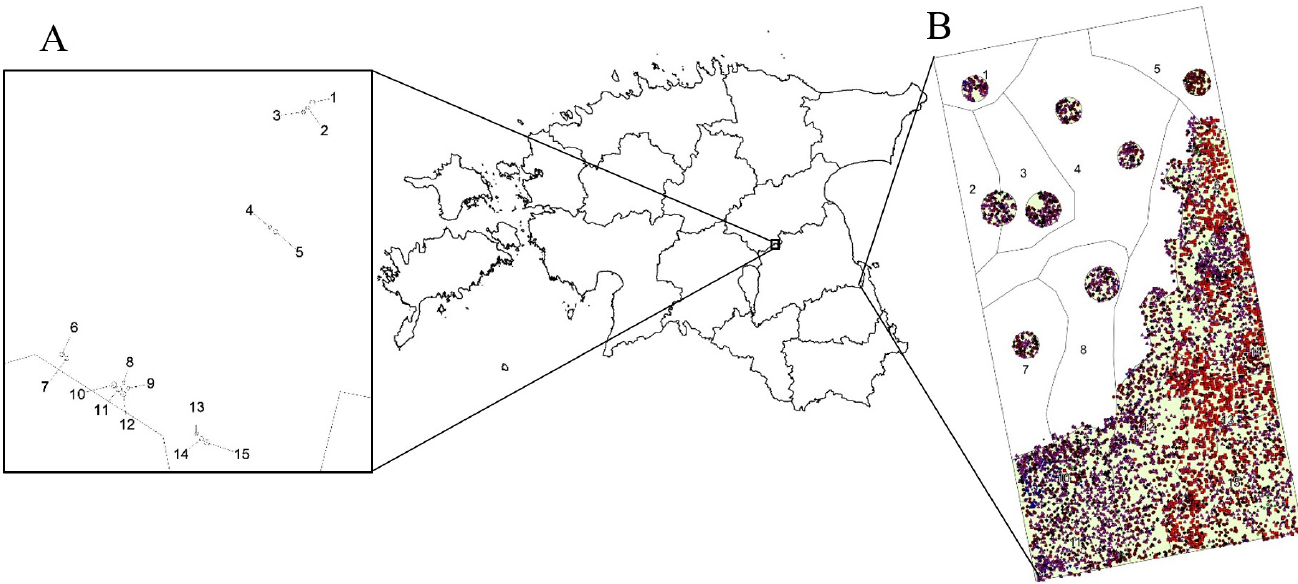
Figure 1. Location of study sites. ( A ) Placement of Estonian Network of Forest Research Plots (ENFRP) plots in central Estonia in the Laeva municipality. ( B ) Measured areas in the Järvselja old-growth compartment following the numbered sub-compartments. The locations of mapped standing live and dead trees are presented (green dots—live trees, blue dots—dead trees, red dots—standing snags). The detailed plot of tree locations in the Laeva site are presented in supplementary materials Figure S3.